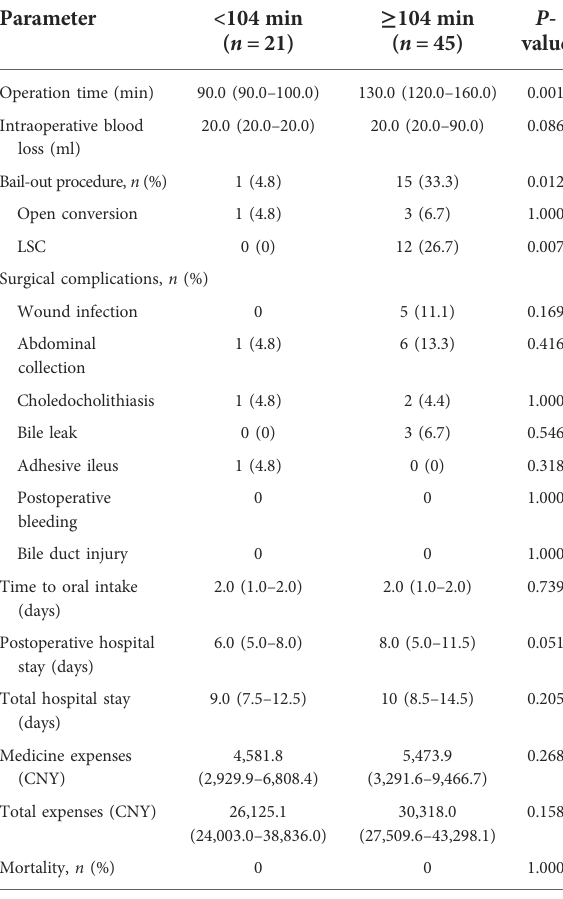
TABLE 3 Comparison of preoperative data according to operation